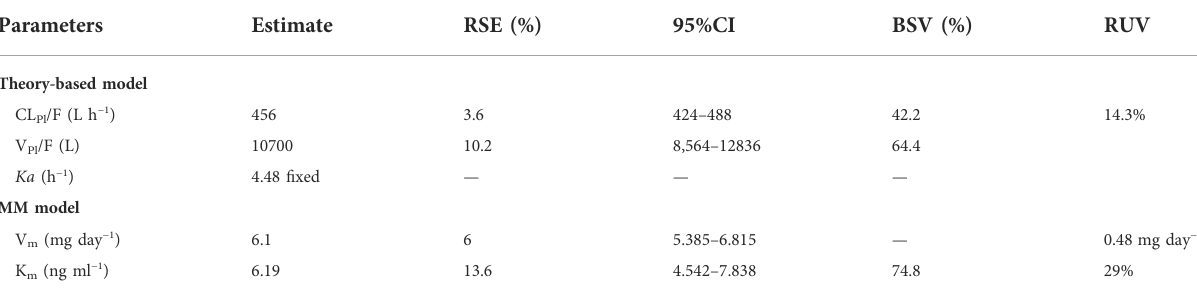
TABLE 3 Population pharmacokinetic parameters of MM and theory-based base models.